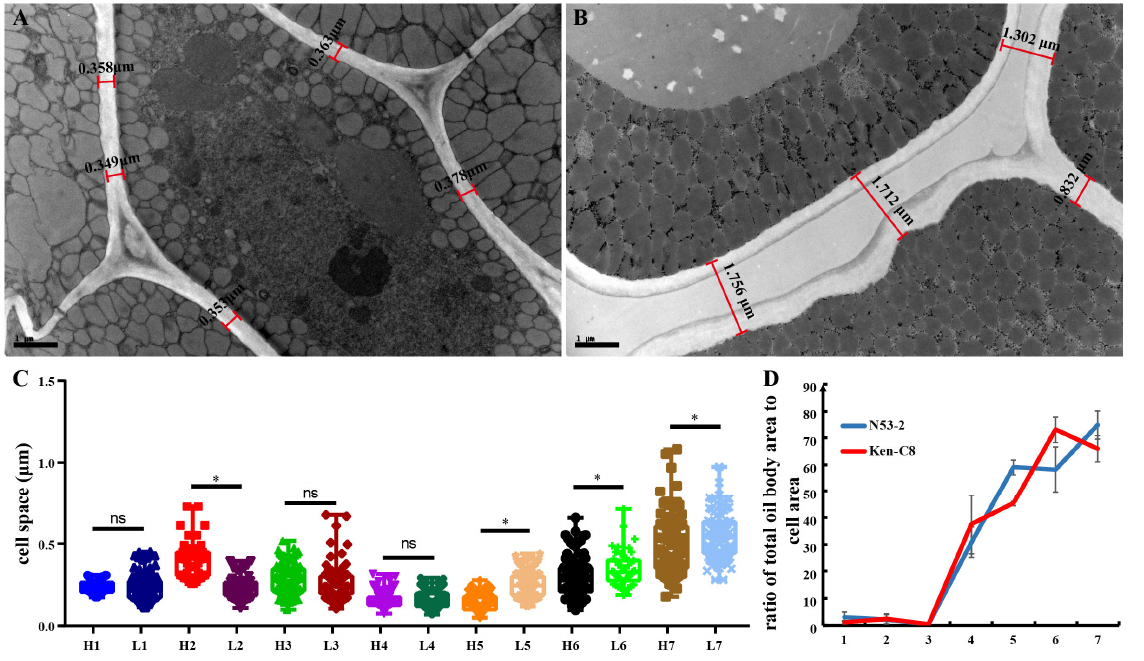
Figure 4. Difference of cell space and oil body area to cell area ratio in HOC and LOC materials: ( A ) TEM images of seeds taken 48 days after fertilization in N53-2, bar = 1 µm; ( B ) TEM images of seeds taken 48 days after fertilization in Ken-C8, bar = 1 µm; ( C ) boxplot of cell space for seeds at different stages; *, p < 0.05; ns, no significant difference; and ( D ) variation in the ratio of total oil body area to cell area within developing seeds of N53-2 and Ken-C8.